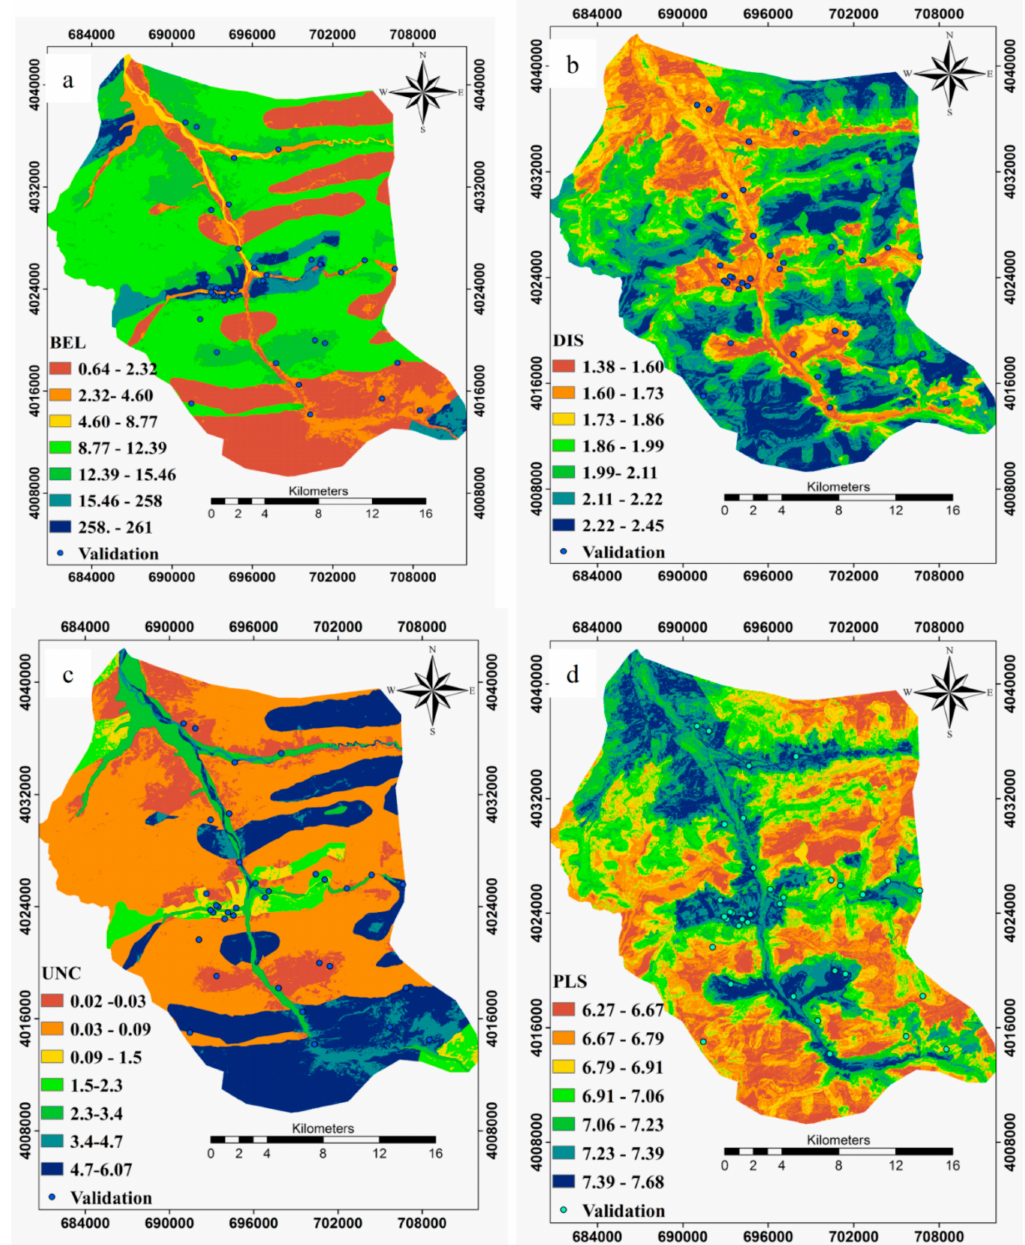
Figure 4. The combined results of the EBF model: ( a ) belief, ( b ) disbelief, ( c ) uncertainty, and ( d )